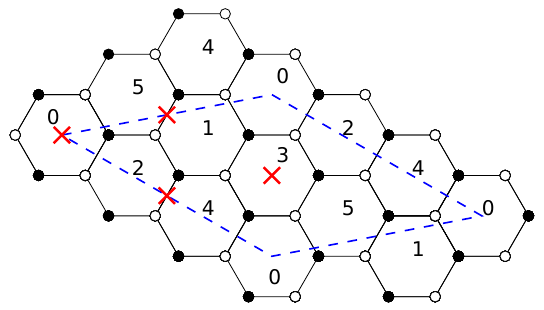
Figure 1 . The C 3 = Z dimer. The theory is chiral, with 6 gauge factors and 18 bifundamental 6 0 chiral super(cid:12)elds X ij . The parallelogram is a possible choice of unit cell. Red crosses represent (cid:12)xed points under the orientifold